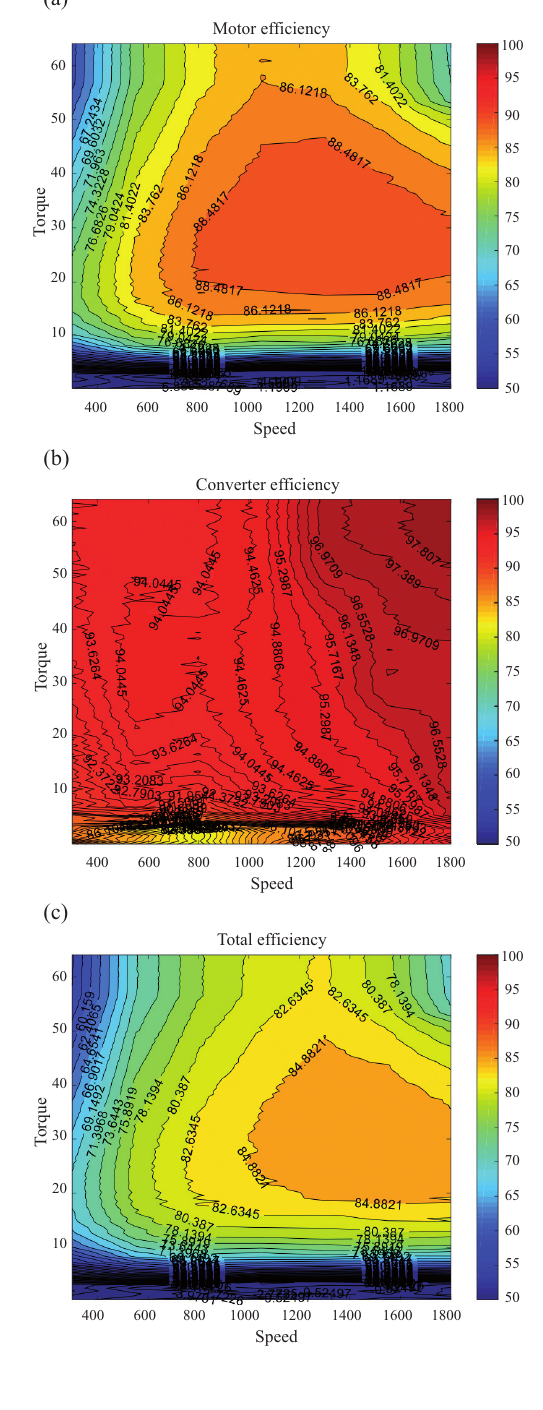
Fig. 4. Efficiency maps of the studied PMSynRM (a), feeding PMSynRM frequency converter (b), and the whole PMSynRM motor­drive system (c).